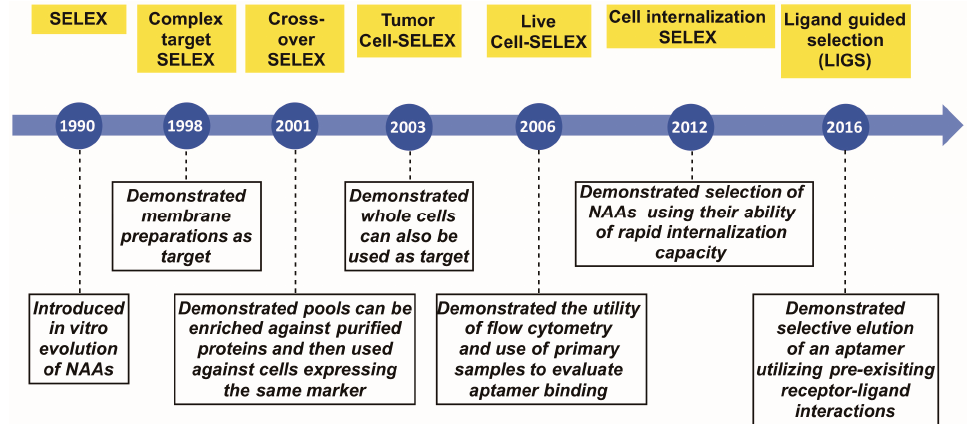
Figure 1. Progression of SELEX methods against complex targets.